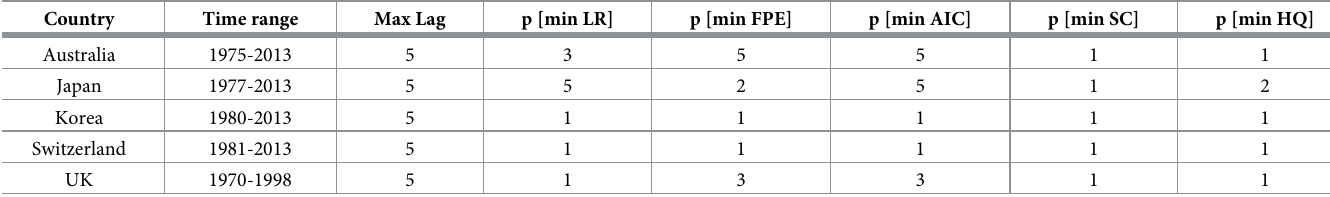
Fig 9. Inverse roots of AR characteristics polynomial for British data when P = 2 (proposed model). https://doi.org/10.1371/journal.pone.0229937.g009 Table 12. Lag length selection (Fisherian model).